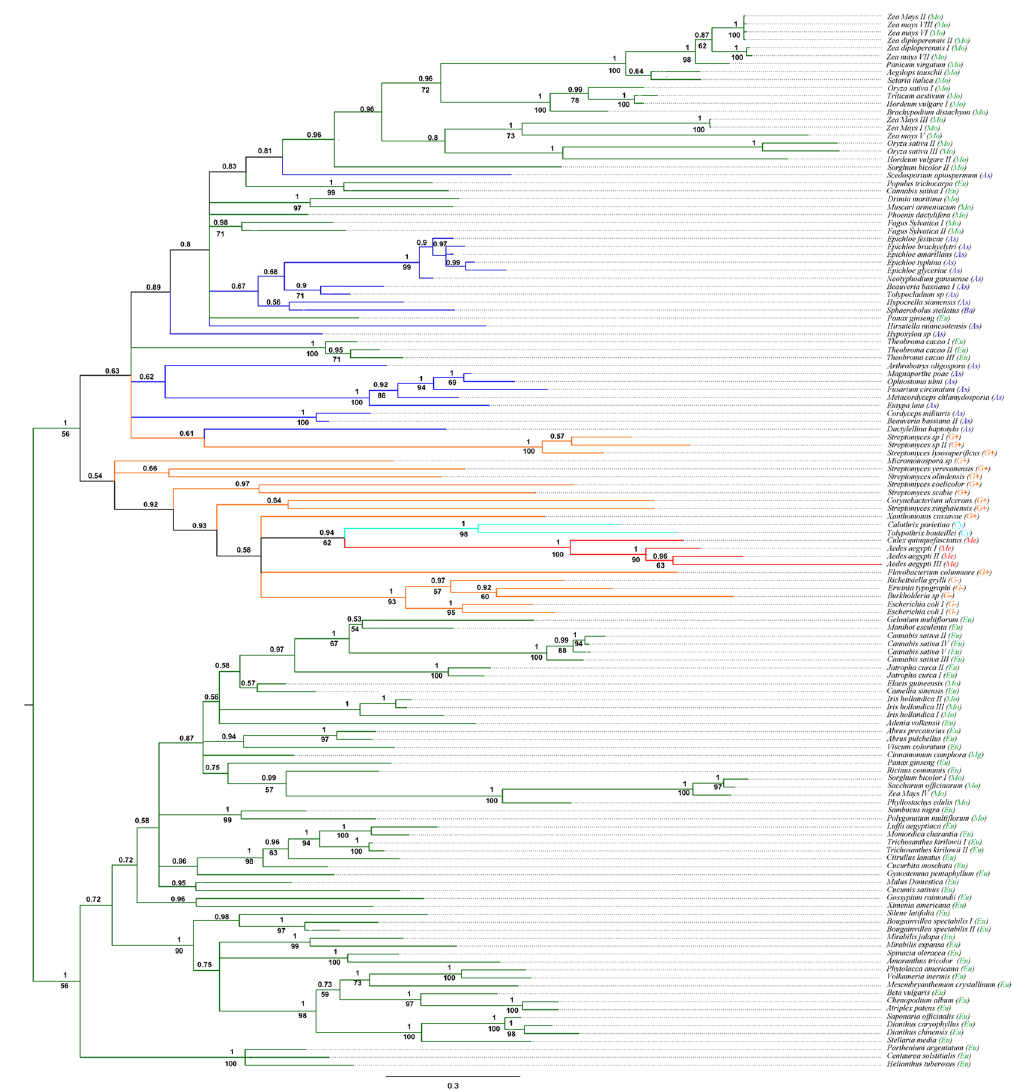
Figure 2. Phylogenetic tree of RIP proteins family. Bayesian tree topology based on a matrix analysis of 133 proteins sequences with 209 informative sites is presented. Numbers above branches indicate PP support values. Bootstrap values (BS) > 50% are shown below branches for nodes where topology of ML analysis was coincident with Bayesian inference. Lineages are indicated by different colors as follows: green (Plantae, including Mo: monocots; Eu: eudicots and Mg: magnoliids), blue (Fungi, including As: Ascomycota and Ba: Basidiomycota), red (Me: Metazoa), orange (Bacteria, including G + : Gram positive, G-: Gram negative, and excluding Cyanobacteria) and turquoise (Cy: Cyanobacteria). The clade of Culicinae RIPs is emphasized with red branches. Information related to the sequences used to infer these trees is available in Supplementary Table